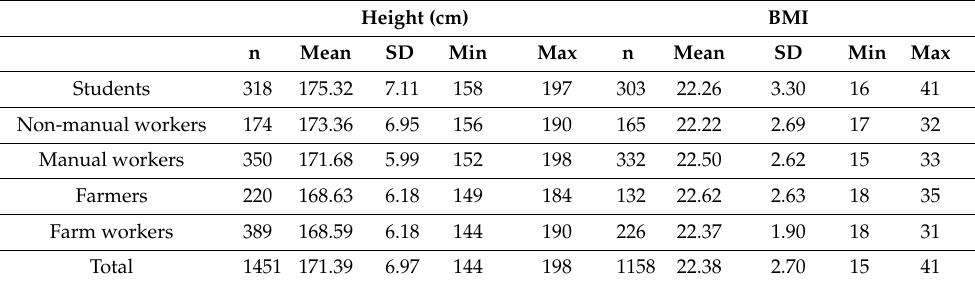
Table 5. Summary statistics by social class group (full sample).